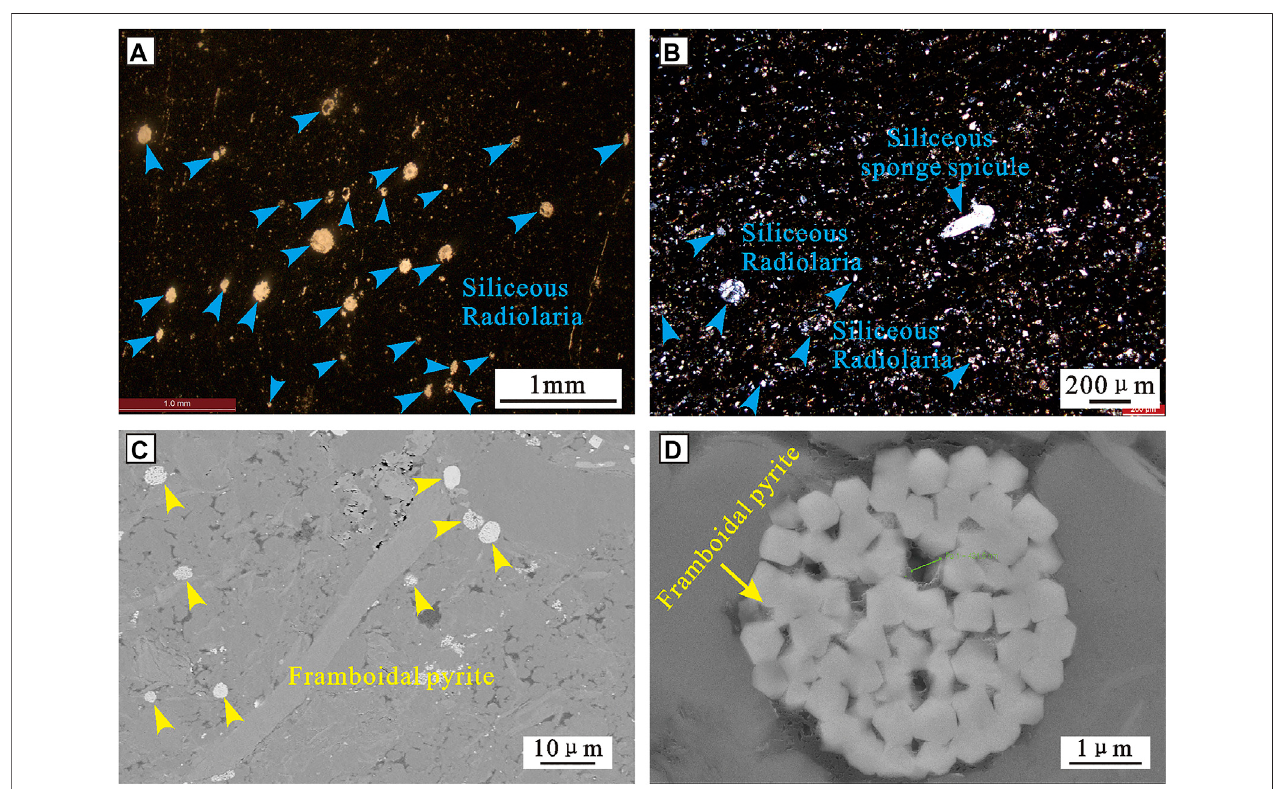
FIGURE 4 | Microscopic images of the black shales of the Wufeng Formation and the lower Longmaxi Formation in the Upper Yangtze Region. (A) Extensive presence of siliceous Radiolaria in the black shales, with diameters generally between 50 and 200 μ m. (B) Siliceous sponge spicule and Radiolaria in the black shales, siliceous sponge spicule with a diameter of approximately 50 µm and length of approximately 300 μ m, and siliceous Radiolaria with diameters of approximately 20 – 150 µm. (C , D) Framboidal pyriteintheblackshales,withdiametersgenerallybetween2and5 μ m (A , B) arepolarizedlightmicroscopyimages. (C) and (D) are scanning electron microscopy